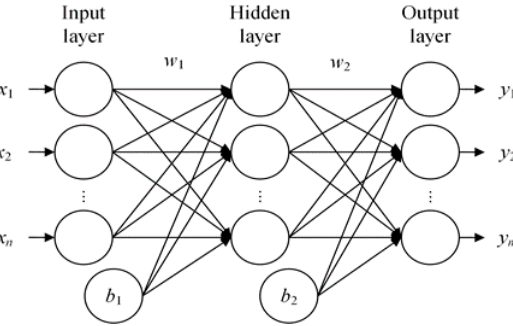
Figure 4. Construct of neural network.